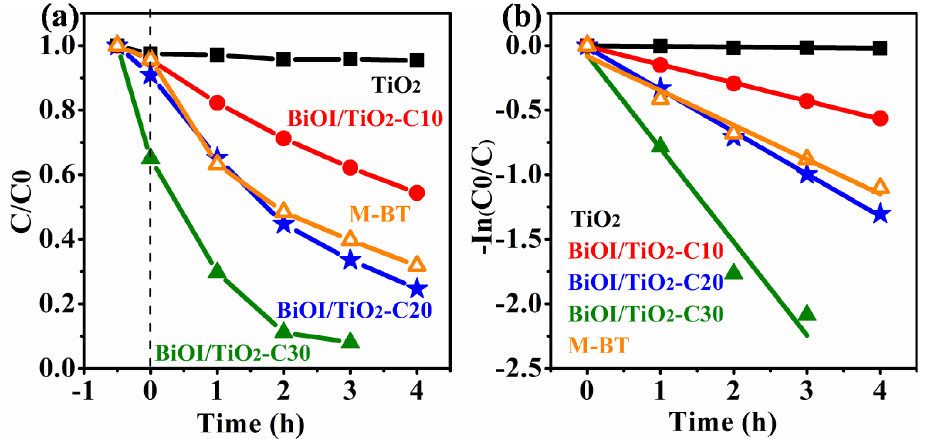
Figure 7. ( a ) Degradation curves of MO under visible light irradiation; and ( b ) the apparent first ‐ order kinetics fitting over different samples.